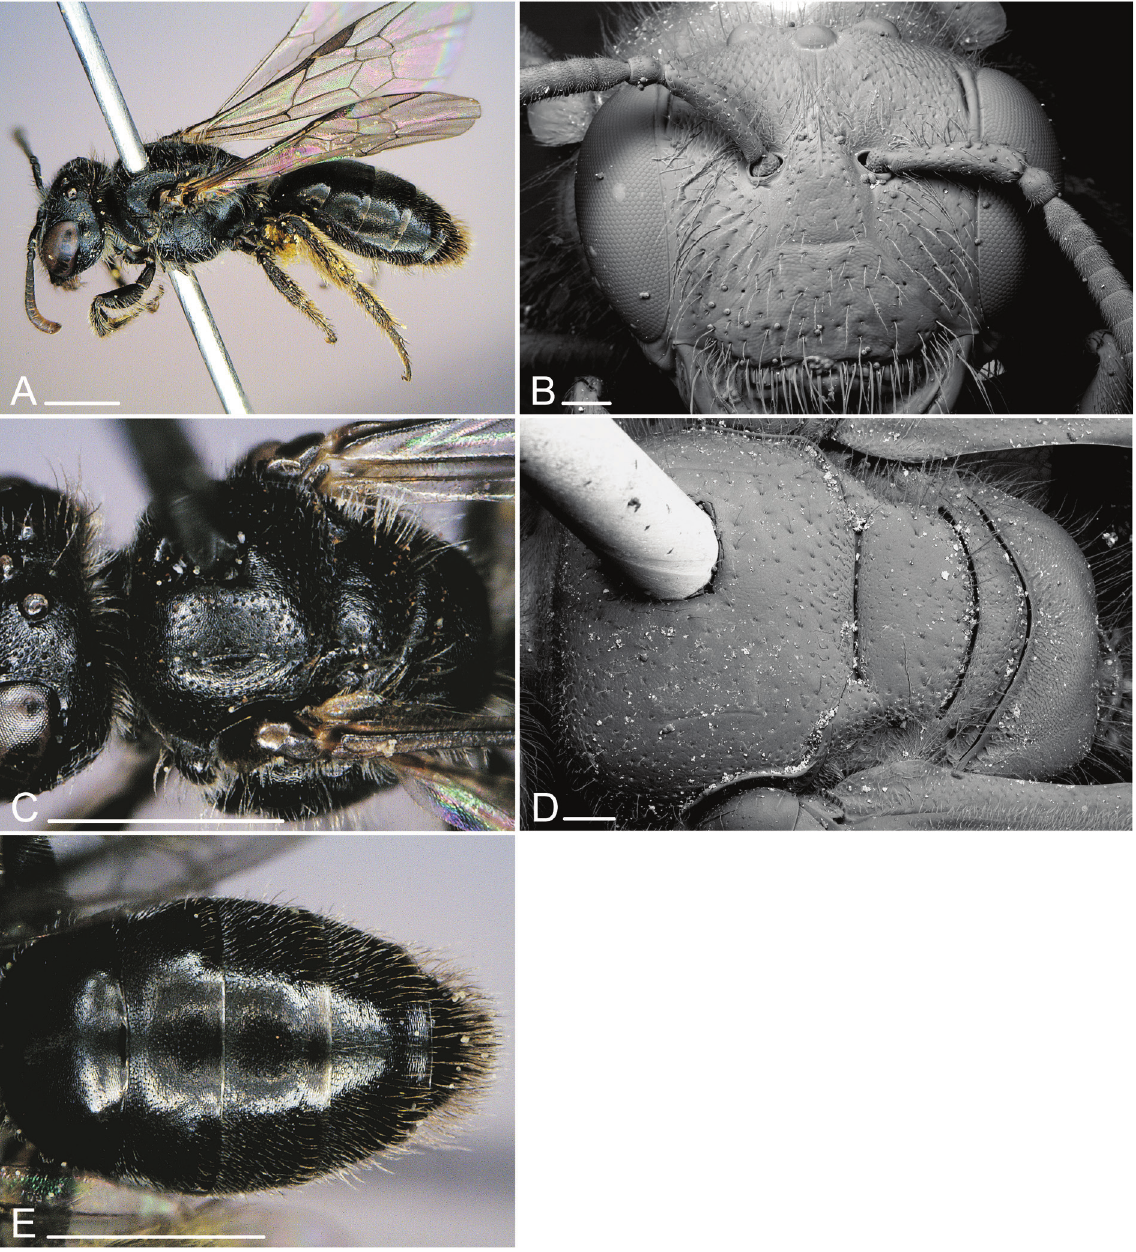
Fig. 26. Scrapter roggeveldi sp. nov., ♀. A . Lateral view. B . Head (SEM). C . Thorax (dorsal view). D . Thorax (dorsal view, SEM). E . Metasoma (dorsal view). Scale bars: photos: 1 mm, SEM: